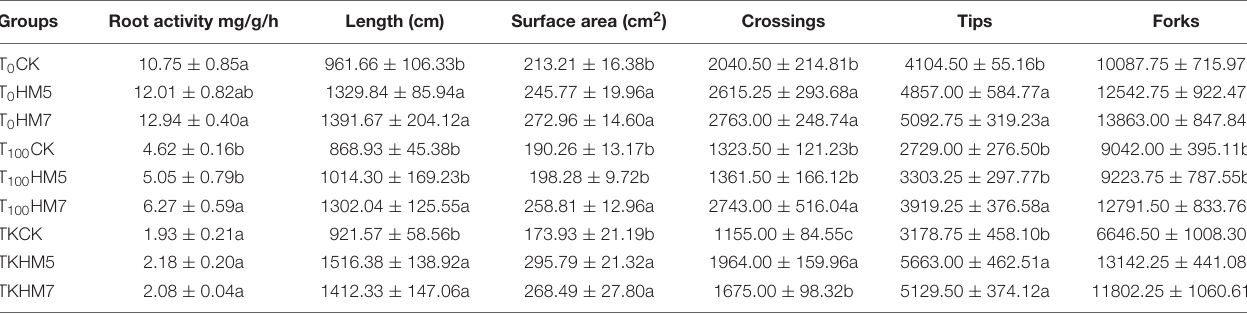
TABLE 3 | Root activity and structure of B.